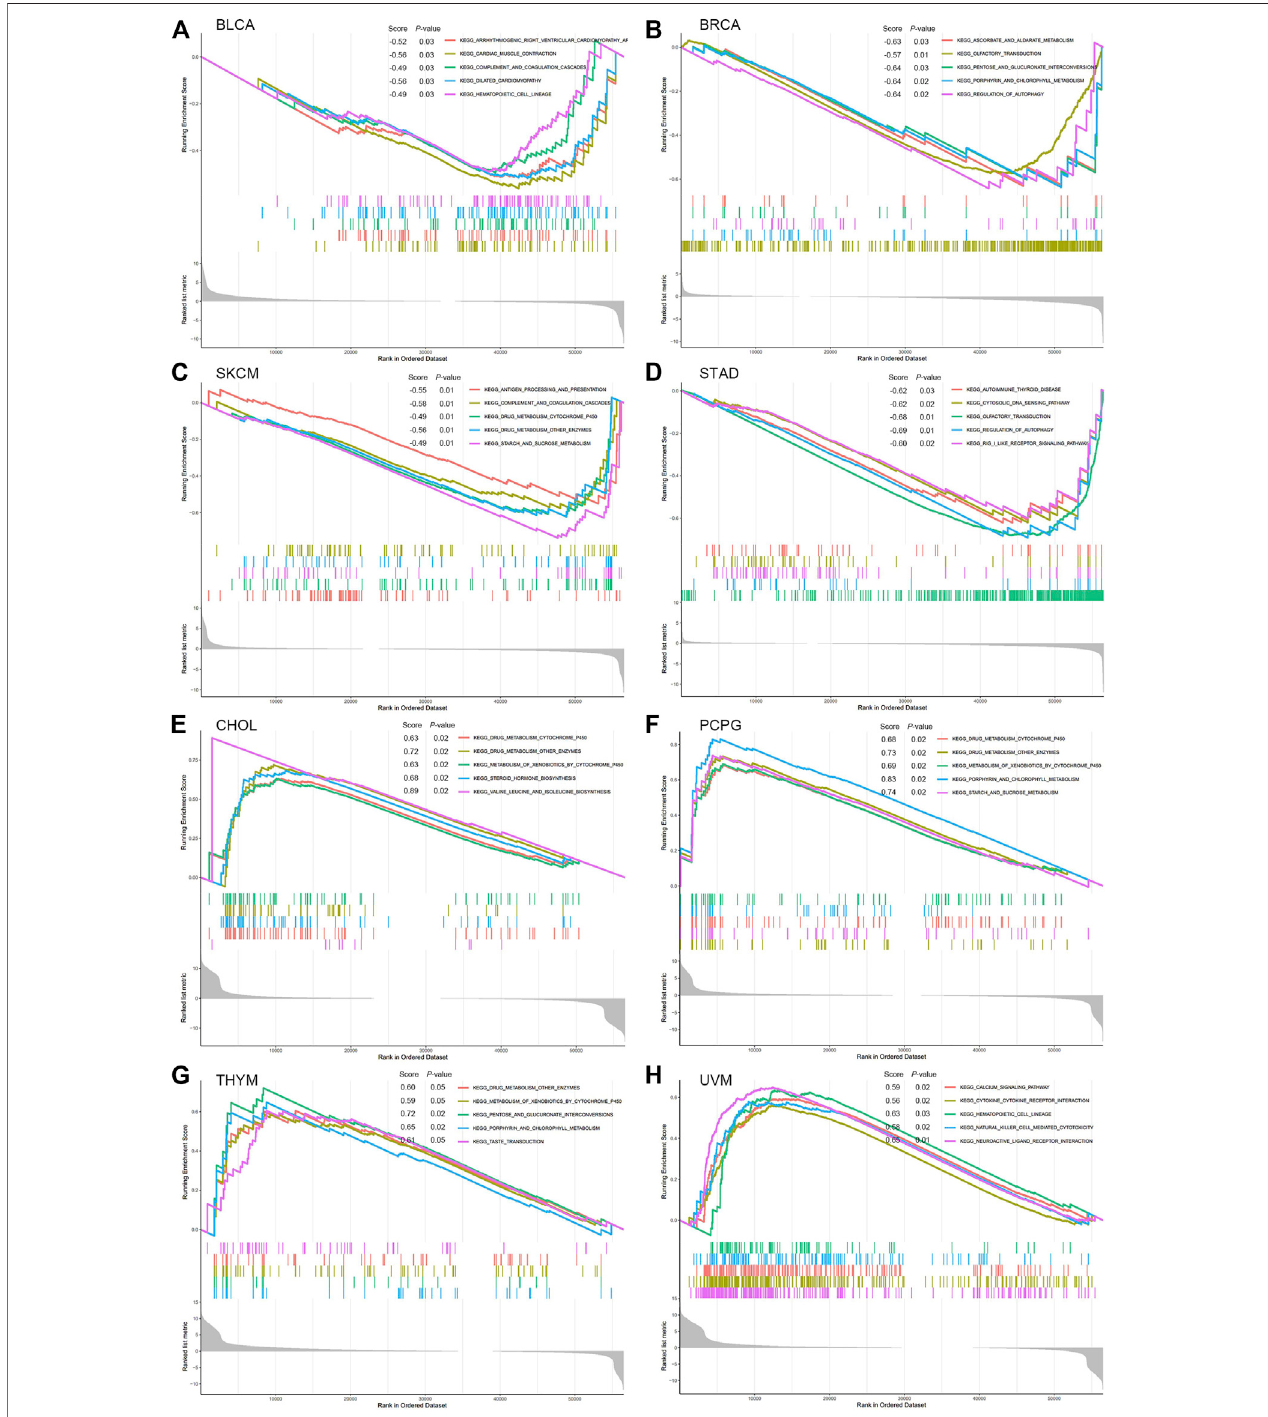
FIGURE 7 | GSEA analysis in KEGG signature of PNPO in BLCA (A) , BRCA (B) , SKCM (C) , STAD (D) , CHOL (E) , PCPG (F), THYM (G) , and UVM (H) . Different color curves represent different functions or pathways. The peak of the upward and downward curve indicates the positive and negative regulation of PNPO, respectively. Score, enrichment score.